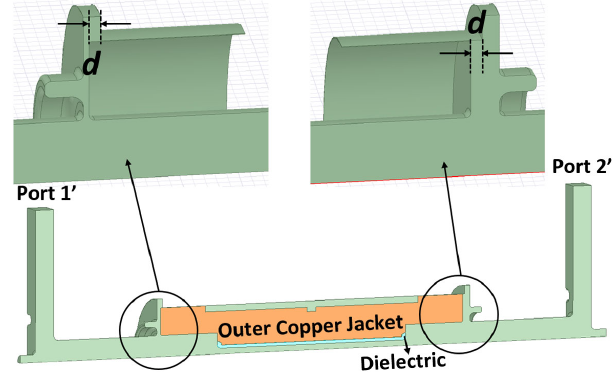
FIG. 25. The choke gap at both sides changes with the moving of the two-halves copper jacket.